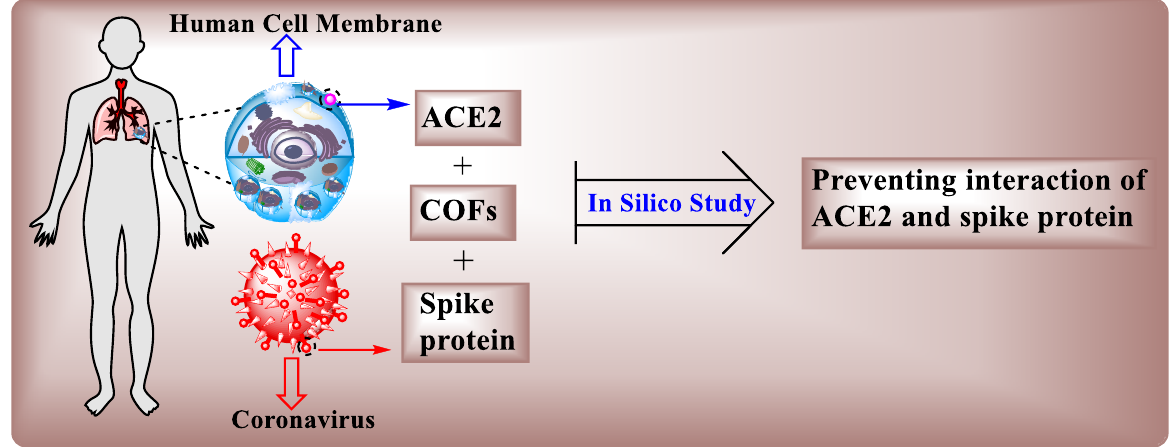
Figure 13. Schematic representation of ACE2 and COF preventing interaction of spike protein with ACE2. “Reprinted from, Atomistic insight into 2D COFs as antiviral agents against SARS-CoV-2. By Jahromi, A.M.; Solhjoo, A.; Ghasemi, M.; Khedri, M.; Maleki, R.; Tayebi, L. Materials Chemistry and Physics 2022, 276, 125382, Copyright (2022), with permission from Elsevier ” [156] .